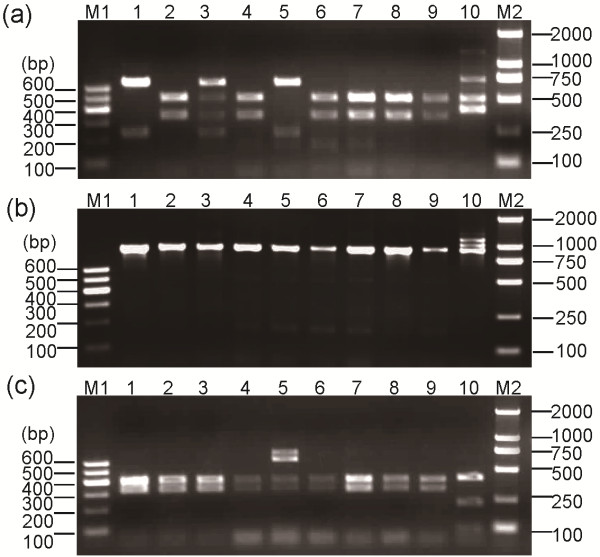
 (a)DraI and (b)XbaI PCR-RFLP profiles of esterase B and (c)ApaLI PCR-RFLP profiles of esterase A from the TAA population. M1, Marker I; M2, Marker D2000; 1–10, as described in Figure 7.